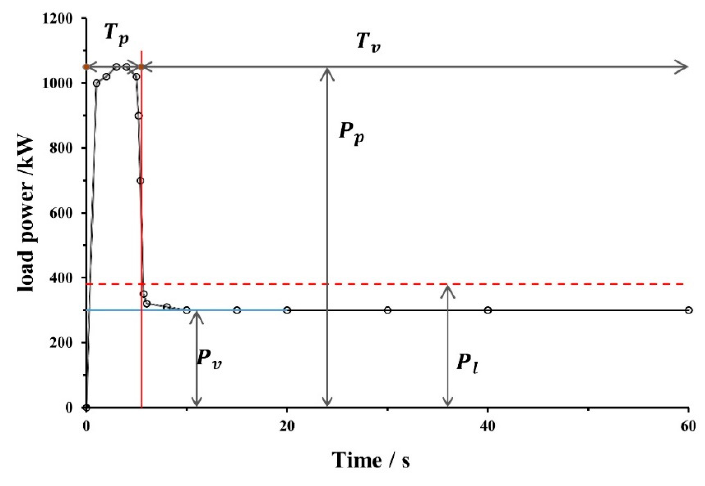
Figure 4. Theoretical periodical mode of the peak-valley load power. Table 1. Theoretical parameters and values in the analytical peak load leveling mode.